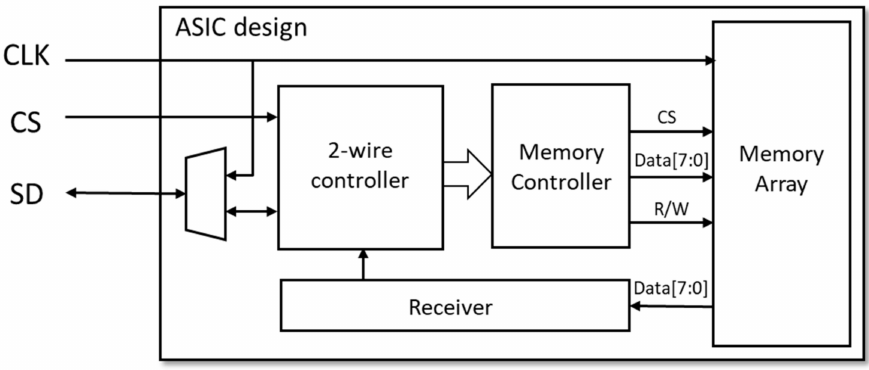
Figure 11. Application-specific integrated circuit (ASIC) design